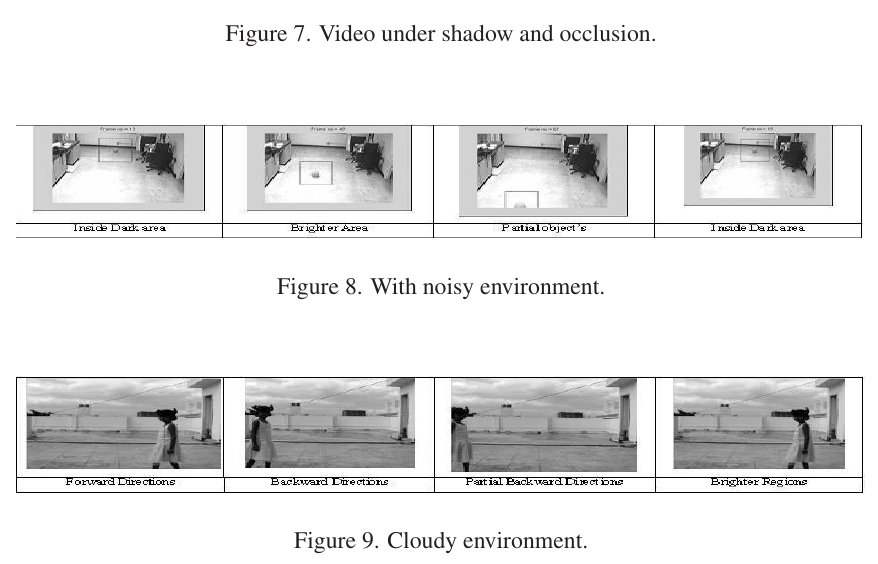
Figure 9. Cloudy environment.